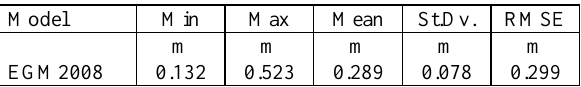
Table 1. Statistical values of the residuals obtained in 20 CPs for EGM2008.